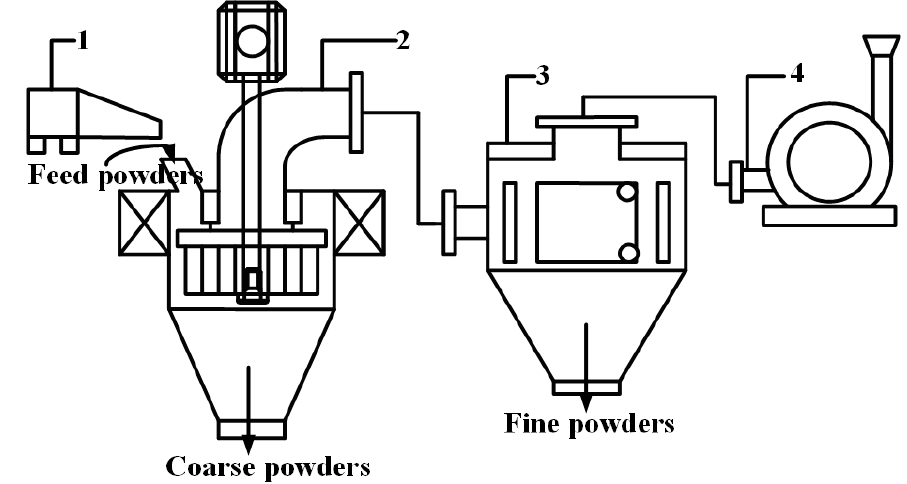
Figure 3. Schematic outline of classification process used in this study. 1: vibratory feeder, 2: turbo air classifier, 3: dust collector, and 4: centrifugal fan.